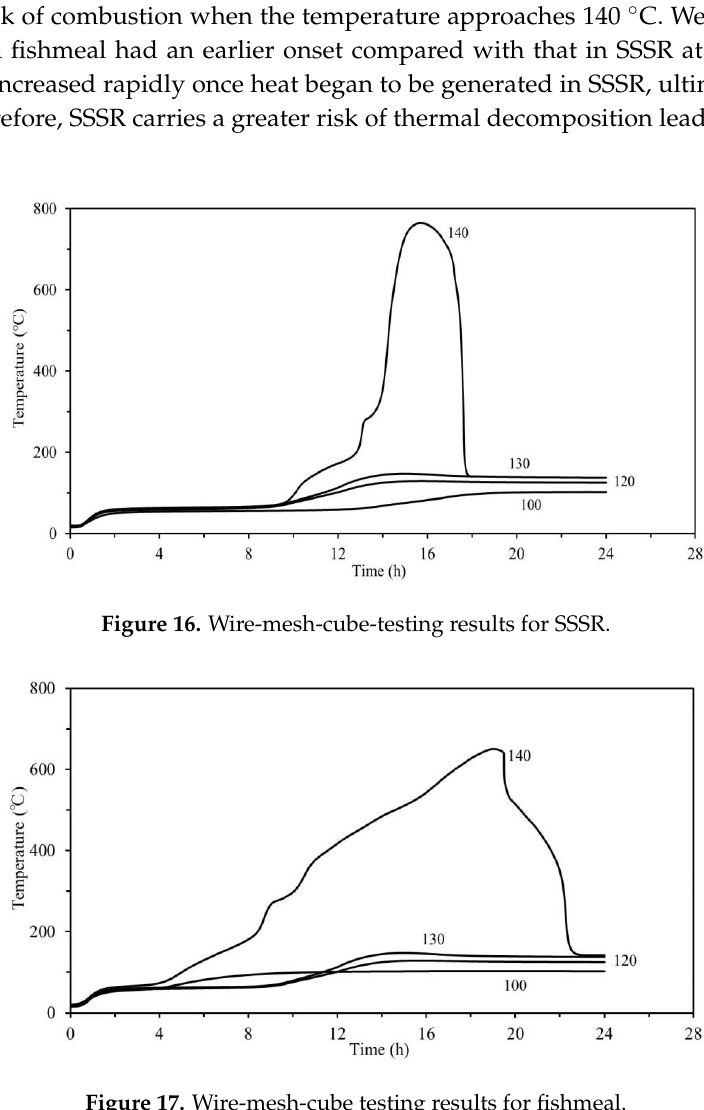
Figure 17. Wire-mesh-cube testing results for fishmeal.